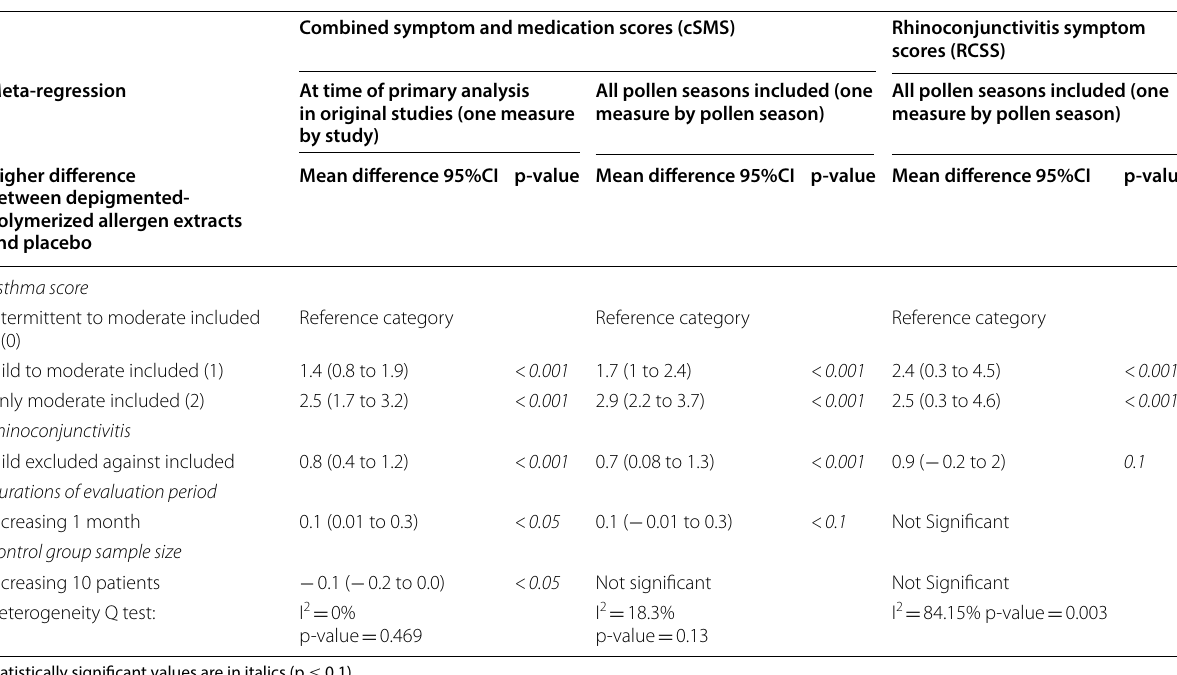
Statistically significant values are in italics (p